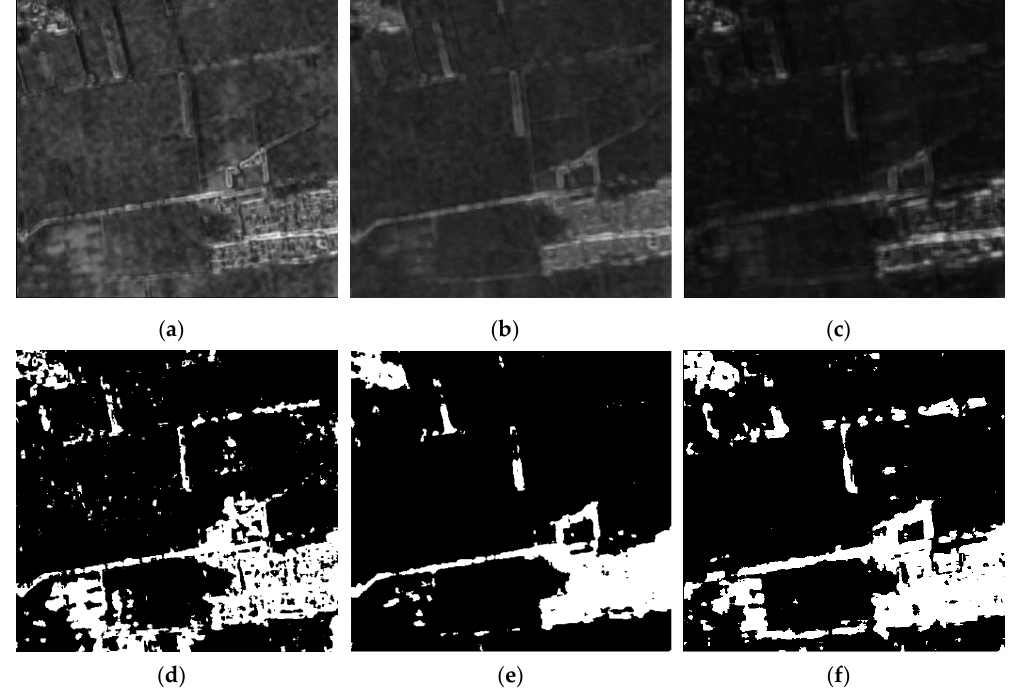
Figure 10. The results of change magnitude images and the binary change maps for data set 2. ( a ) change magnitude image ( n = 3). ( b ) change magnitude image ( n = 9). ( c ) change magnitude image ( n = 15). ( d ) binary change map ( n = 3). ( e ) binary change map ( n = 9). ( f ) binary change map ( n = 15).